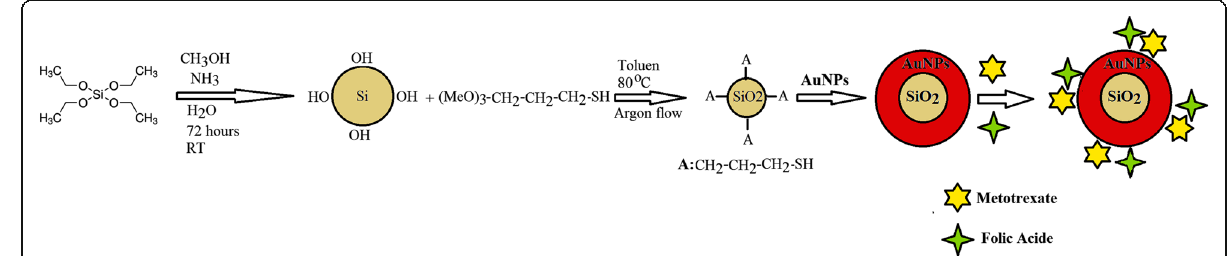
Fig. 1 The stepwise synthetic scheme for the preparation of folate and methotrexate loaded biocompatible Au@SiO 2 NPs